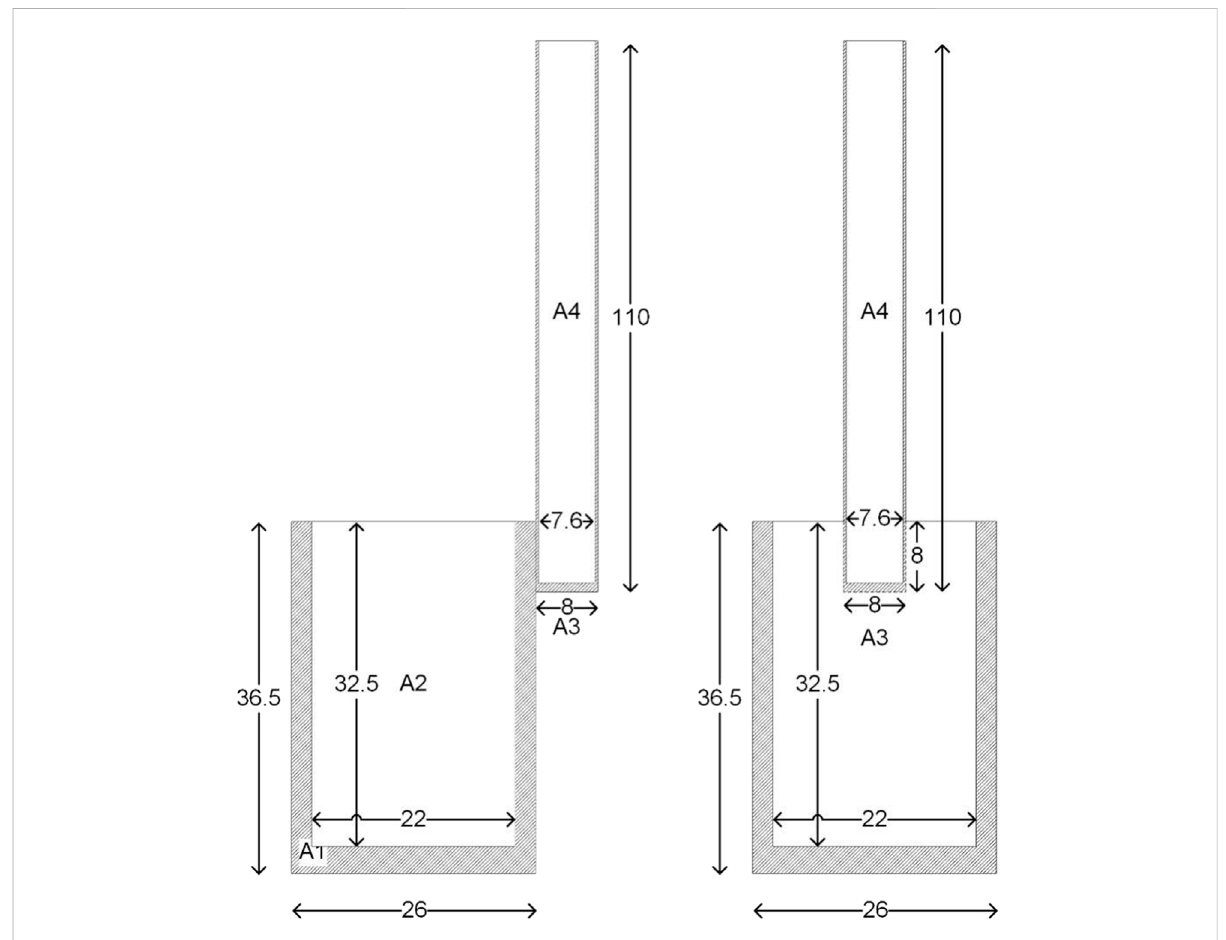
FIGURE 5 Sizes of the Chinese stove A of the left view and front view (unit: